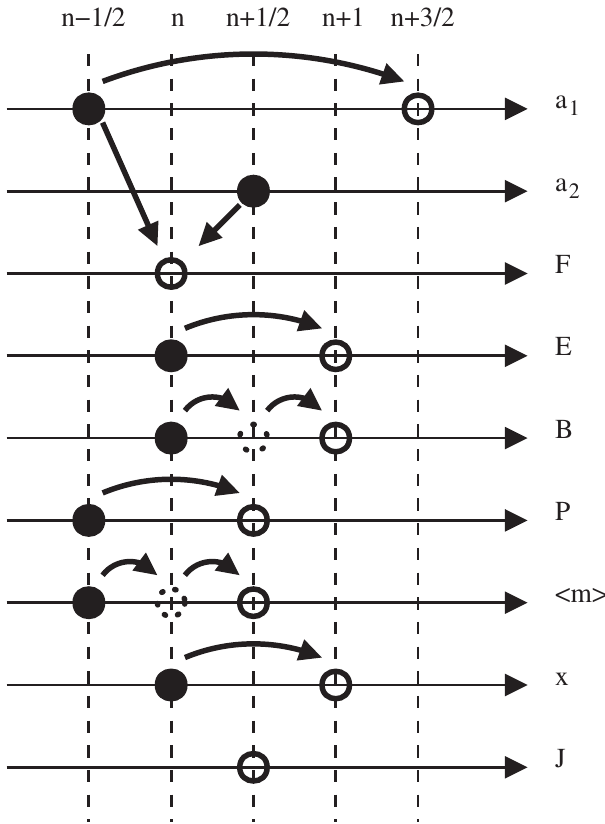
FIG. 1. Time stepping of the envelope field solver, the elec- tromagnetic PIC update and the particle dynamics. Full circles indicate the initial state, dotted circles intermediate steps and empty circles the quantities at the end of the time